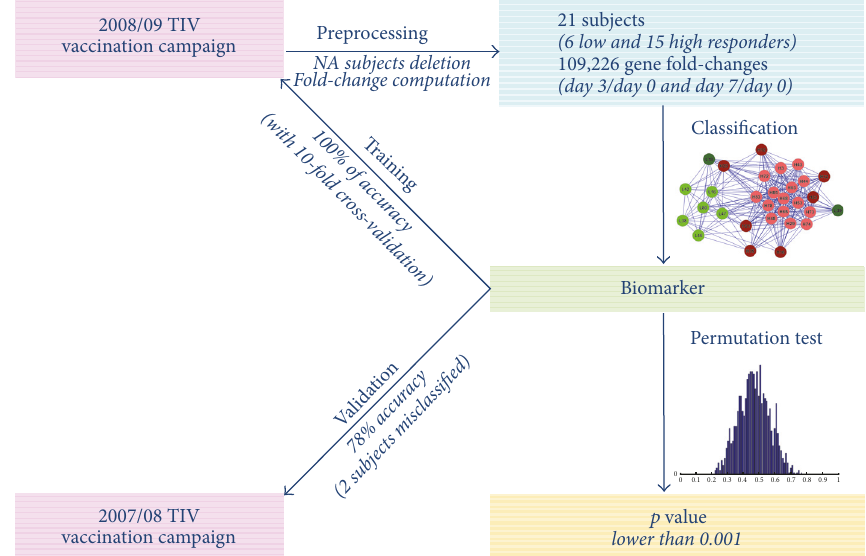
Figure 1: Graphical representation of the analysis pipeline implemented to compute biomarkers (see Materials and Methods). The analysis started with the dataset related to the 2008/09 TIV vaccination campaign (set #2). After a preliminary preprocessing of the dataset for removing subjects with intermediate answer to the vaccine (“NA subjects,” maximum HAI Day 28/ Day 0 across strains equal to 4) and for computing gene fold changes (day 3/day 0 and day 7/day 0), we applied the classification algorithm SCUDO to obtain the biomarker. The classification process on the training dataset exhibited 100% accuracy with a 10-fold cross-validation scheme. Moreover, its statistical significance was assessed by a permutation test providing a 𝑝 value < 0.001. Finally, the identified biomarker was validated using an independent dataset (2007/08 TIV vaccination campaign, set #1). The classification on the validation dataset exhibited 78% accuracy.